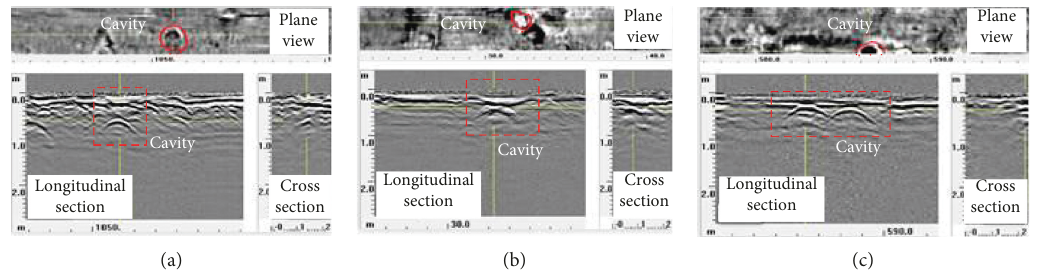
Figure 4: Common types of cavity waveforms. (a) Wedge type. (b) Box type. (c) Continuous type.